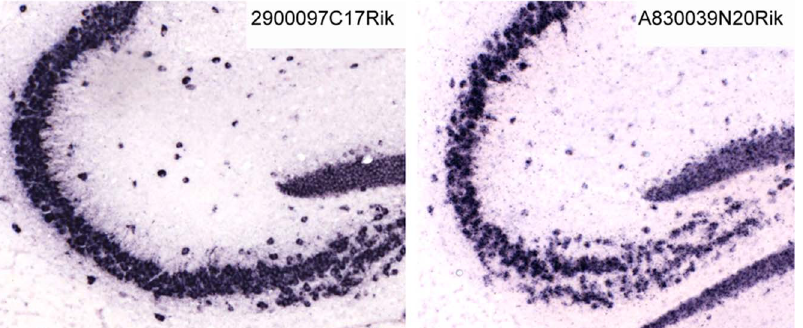
Figure 5. In situ hybridization pattern of the indicated non-coding RNA genes, obtained from the Allen Brain Atlas. For positive and negative control, see Fig.